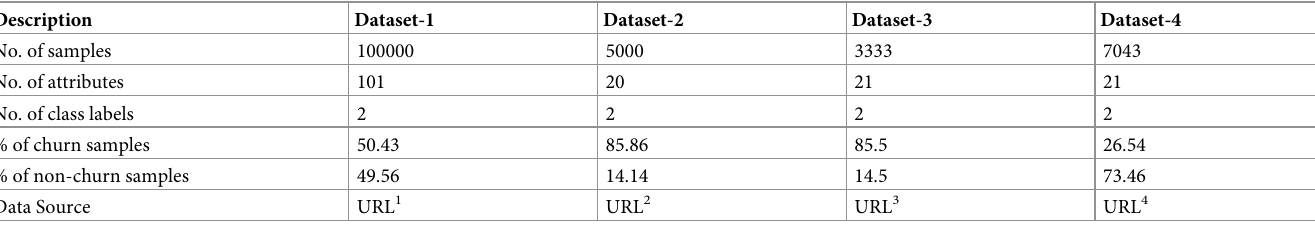
Table 2. Summary of the datasets used in this